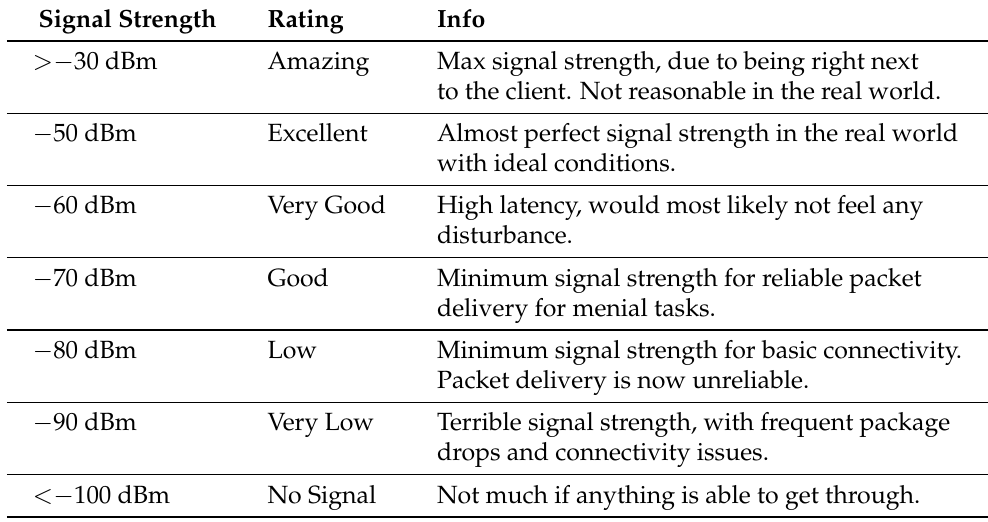
Table 2. Signal strength levels of RSSI [25].